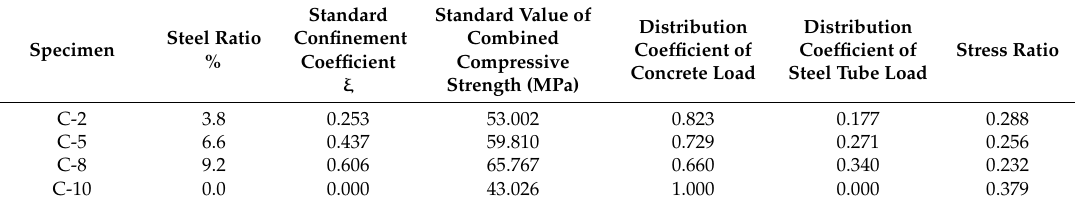
Table 8. Summary of parameters used for studying the confinement effect of the combined structure.